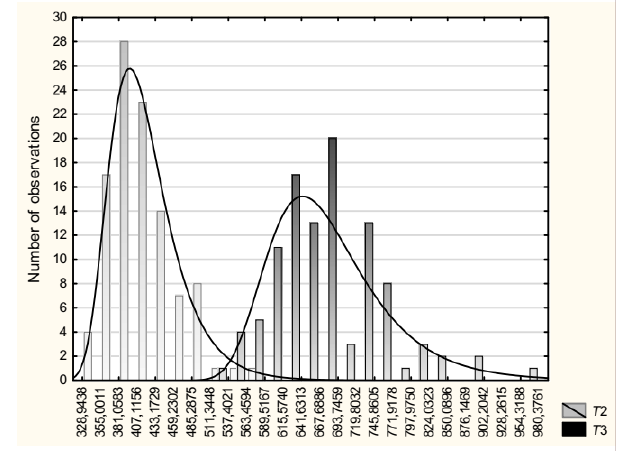
Figure 3. Distributions of RTs from tasks T 2 and T3. The histograms show the fitness of the empirical data to the ex-Gaussian curves, with increased mean RTs and right-side exponential tail in task T 3 comparing with T 2. Axis x—time in milliseconds, axis y—number of observations (See the Supplementary Materials containing the other visualization of RTs-related data from tasks T 1, T 2 and T 3